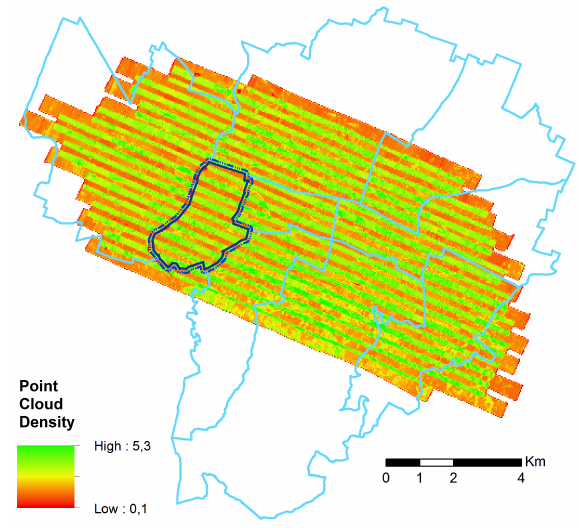
Figure 2: LiDAR data coverage and Bologna district boundaries The laser scanner used by Blom CGR S.p.a. in the flight that took place in 2009 was a Optech ALTM 3033 with the following